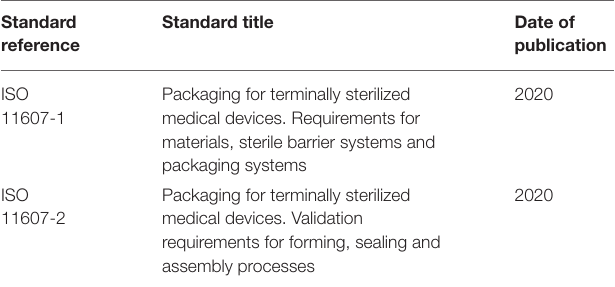
TABLE 4 | Standards for packaging sterile barrier systems.